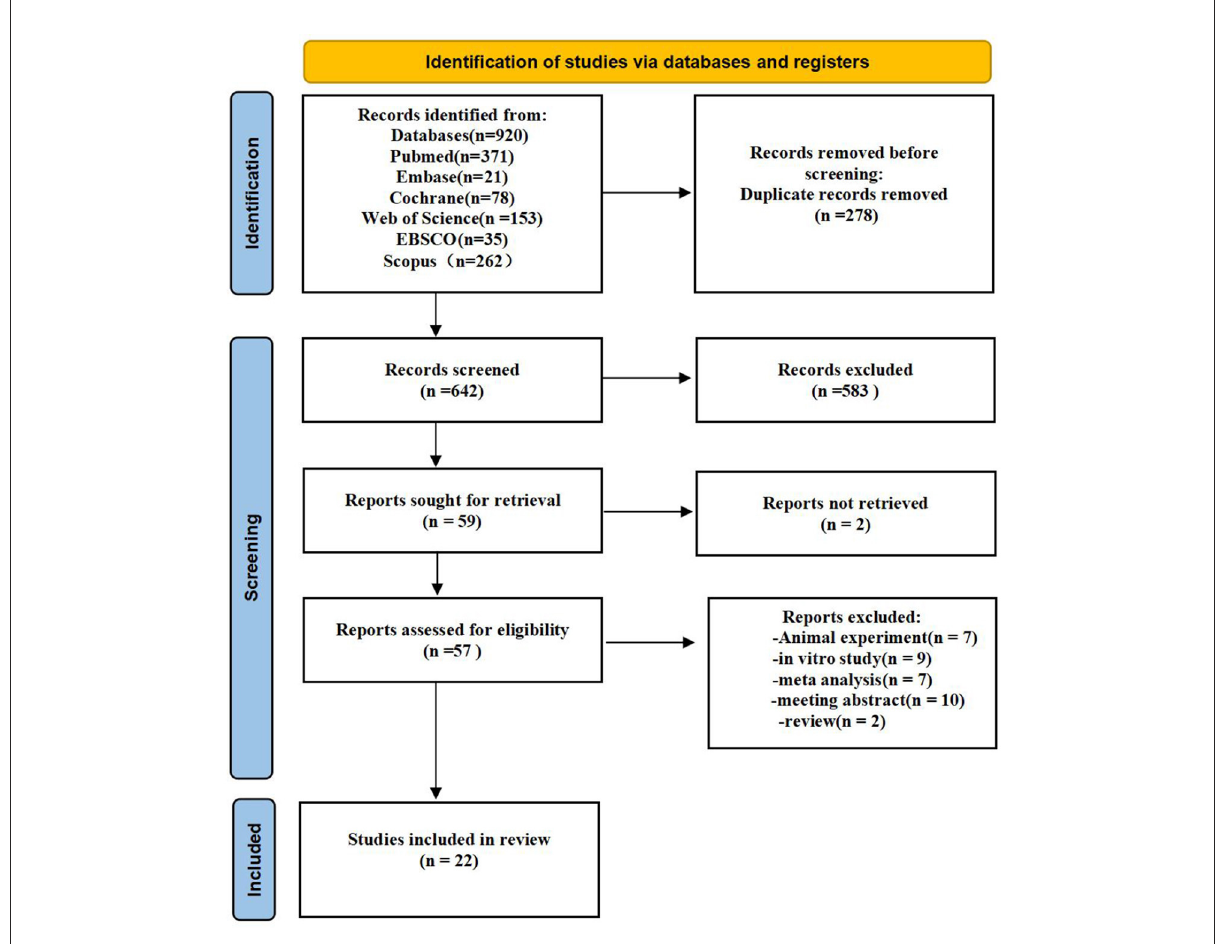
FIGURE1 Flow chart of the study selection